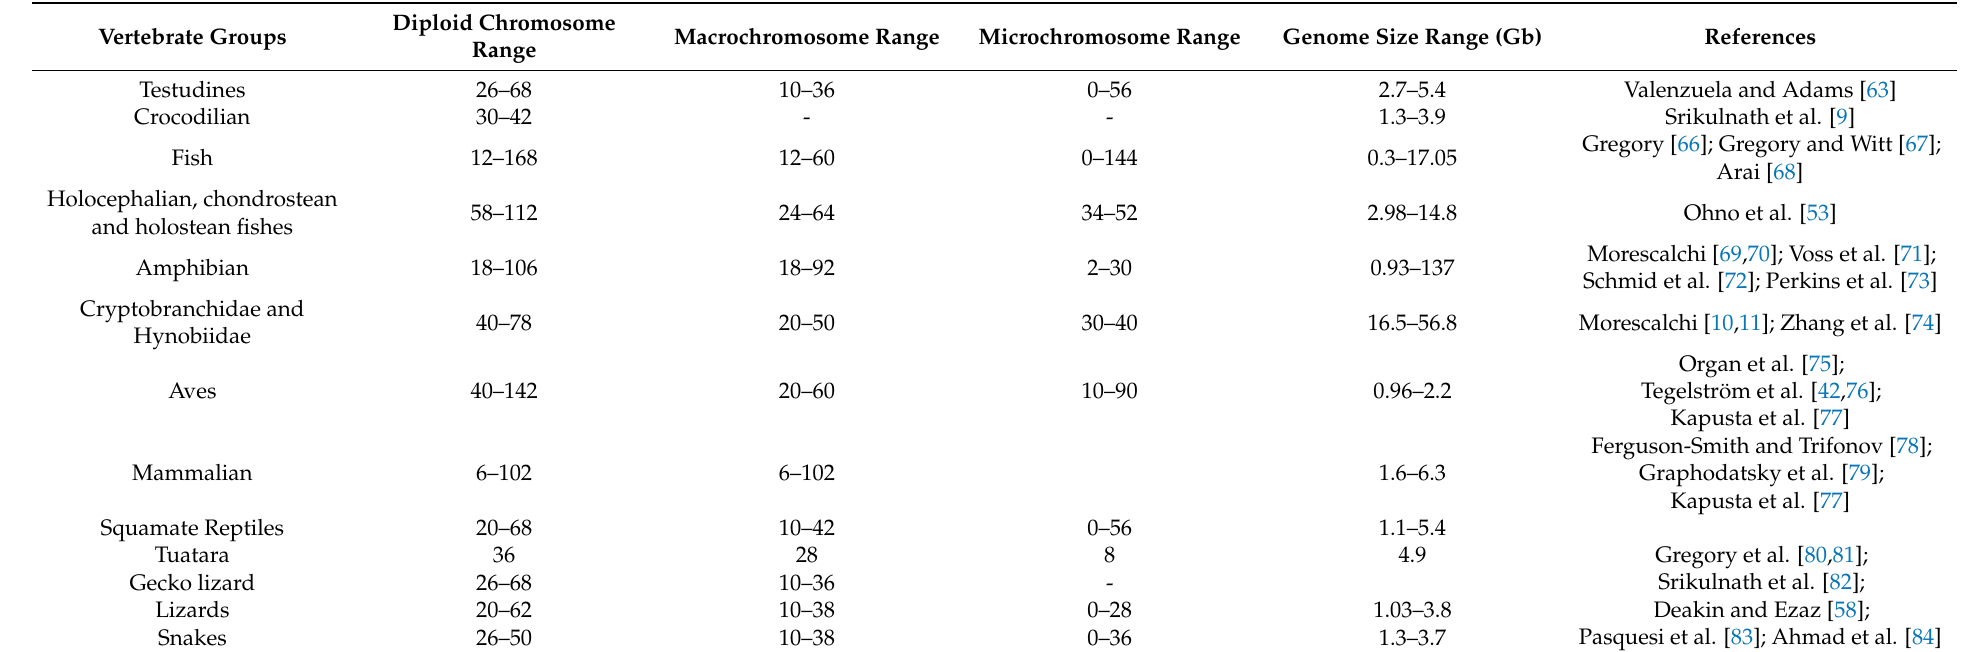
Table 1. Range of genomic features in different classes of